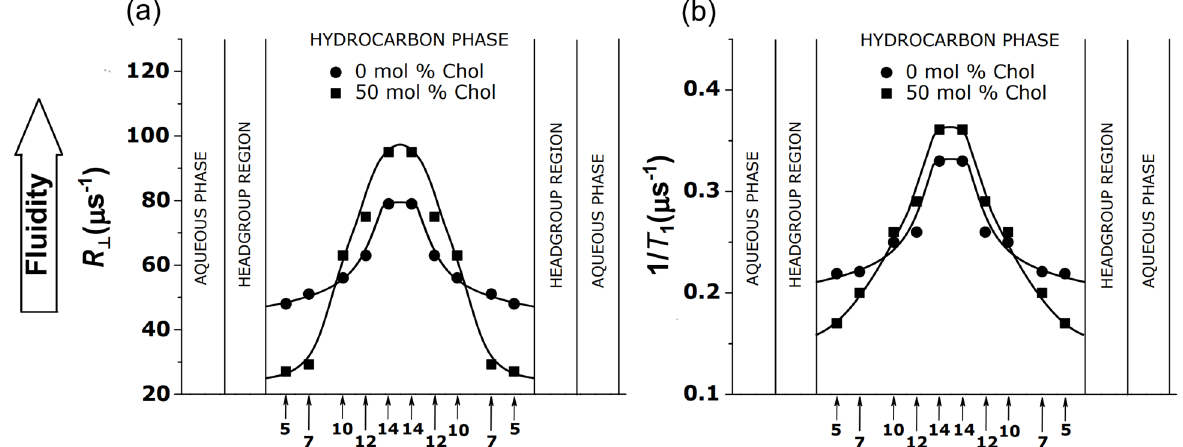
Figure 4. ( a ) Profiles of the rotational diffusion coefficient ( R ⊥ ) obtained with convenient continuous wave EPR technique and ( b ) spin–lattice relaxation rates ( T 1 − 1 s) obtained with n-PC spin labels across DMPC membranes without and containing 50 mol% Chol using SR EPR technique. The nitroxide fragment position on the alkyl chain is indicated by “n.” Measurements were performed at 27 °C for thoroughly deoxygenated membranes. Values of T 1-1 and R ⊥ were taken from [57].